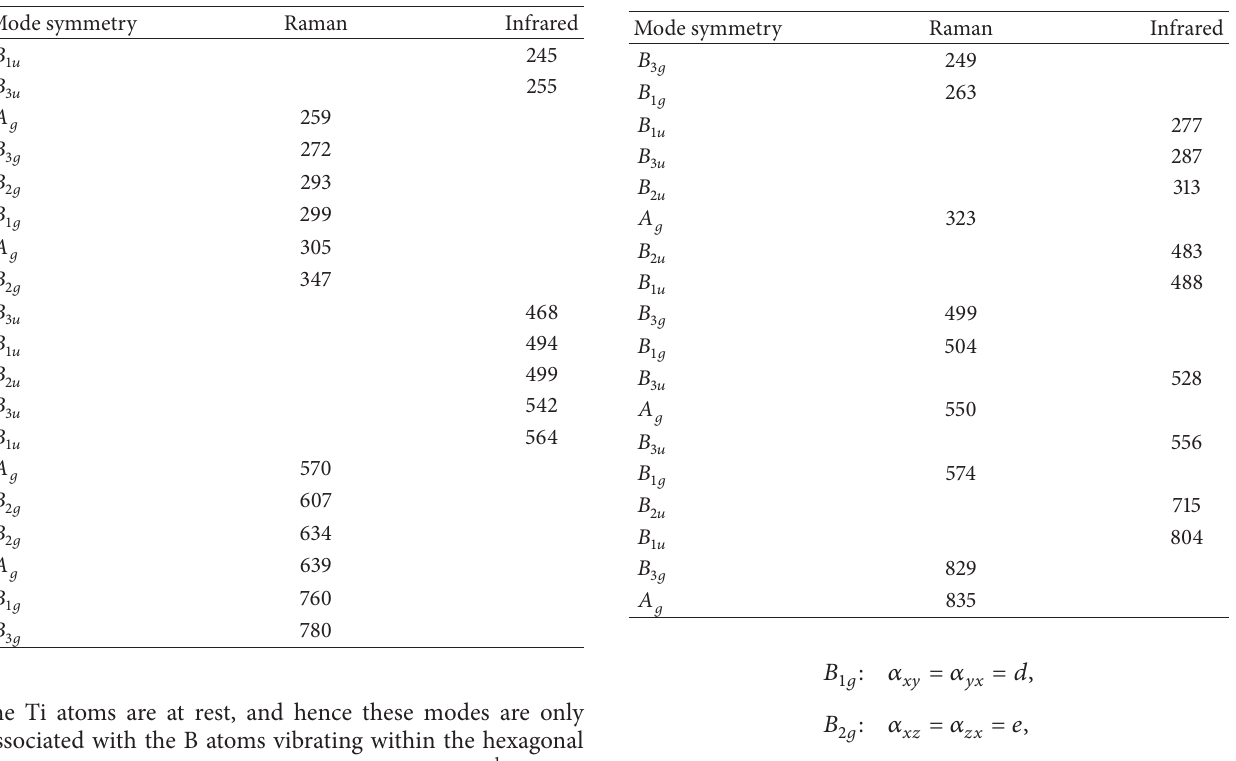
Table 3: Frequencies of the Raman and IR-active phonon modes in TiB. Units: cm −1 .